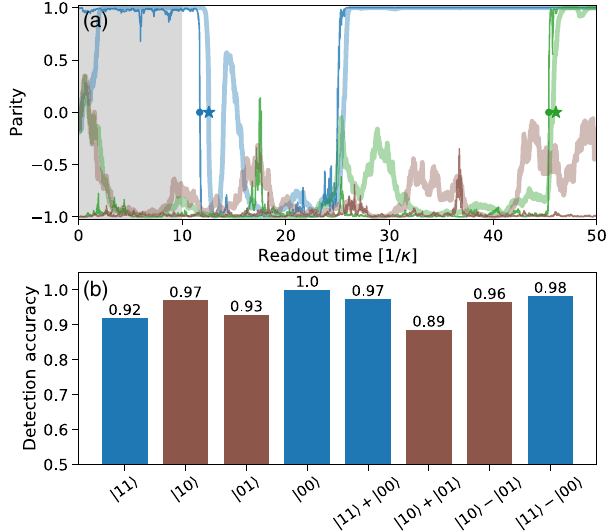
FIG. 9. (a) Ground truth parity trajectories in dark thin lines and corresponding RC parity estimate in light thick lines of the same colors. The times at which the qubit parity jumps are indicated with circles; the resultant RC parity change is denoted with a star. The RC of Figs. 3 and 4 is again used, trained with Q ¼ 40 measurements over the 10 = κ window shaded in gray. (b) Fraction of trajectories for which parity monitoring was successful over the entire 50 = κ monitoring window for each initial state. Failures occur when the RC either predicts a parity change where none occurred or fails to detect a parity change. Odd and even initial states are colored red and blue respectively.